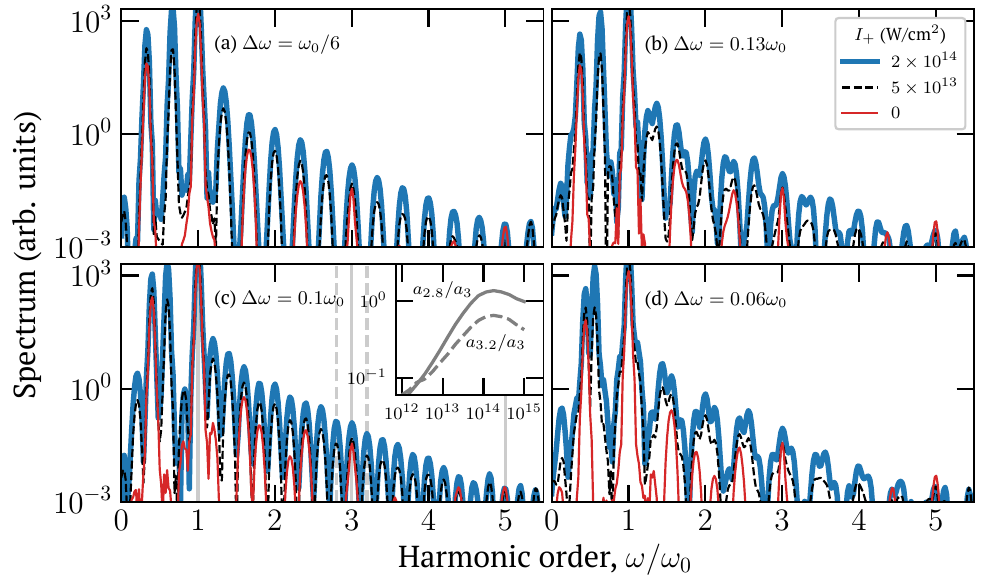
Figure 1. d j / dt squared spectrum from three-color ionizing pulses with ω 0 corresponding to ∆ ω with four different values of ∆ ω = ω = ω 0 /2 λ 0 = 800 nm, ω 0 /6 ( a ), 0.13 ω 0 ( b ), 0.1 ω 0 ± ± = 10 14 W/cm 2 are fixed, for blue lines ( c ), and 0.06 ω 0 ( d ). Intensities I 0 = 10 15 W/cm 2 and I − I + = 2 10 14 W/cm 2 , for black lines I + = 5 10 13 W/cm 2 and for red lines I + = 0. All the phases × × are equal to 0, pulse duration τ p = 50 fs. The inset to subplot ( c ) shows how the ratios between the amplitudes of different peaks depend on I + : a 2.8 / a 3 (solid line) and a 3.2 / a 3 (dashed line), where a n is the amplitude of the d j / dt squared spectrum at ω = n ω 0 . I 0 and I are fixed at the same values as − on the other